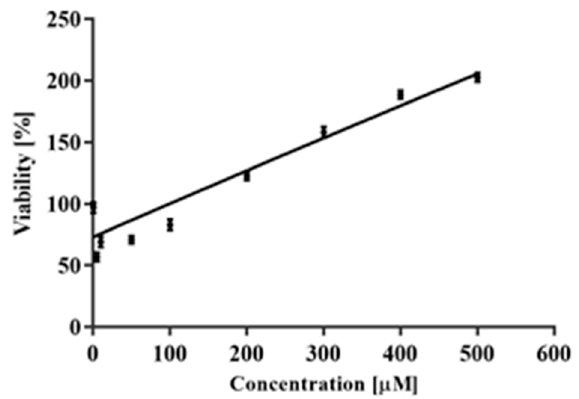
Figure 2. The e ff ect of CAPE on PBLs growth after 72 h incubation evaluated by MTT assay (the Figure 2. The effect of CAPE on PBLs growth after 72 h incubation evaluated by MTT assay (the mean mean ± ± SEM).